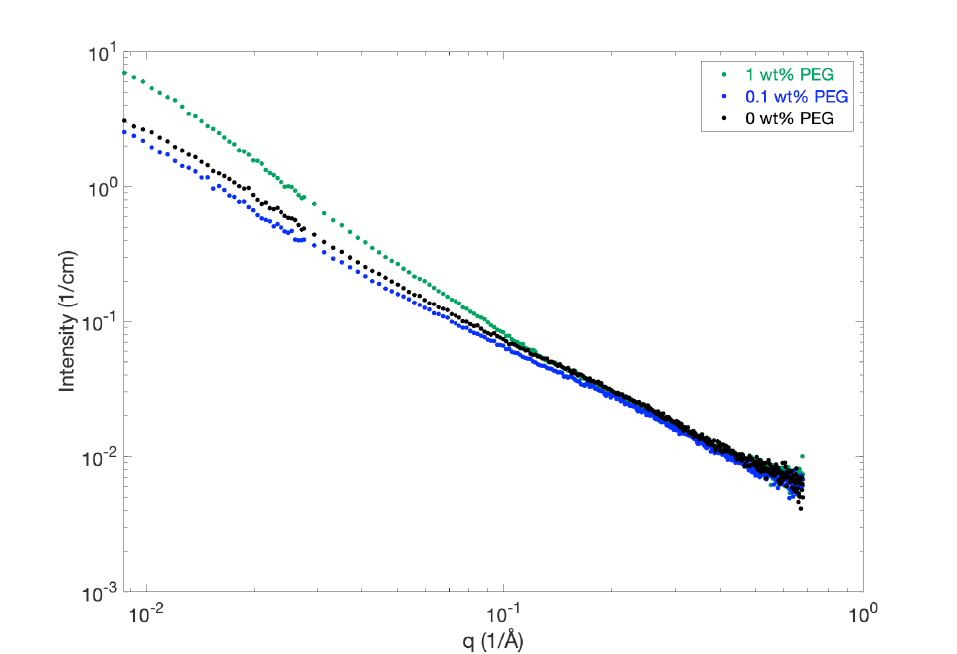
Figure 7. SAXS patterns for 4 wt % MCC dissolved in 8 wt % NaOH with/without a varying content of PEG with an average molecular weight of 200